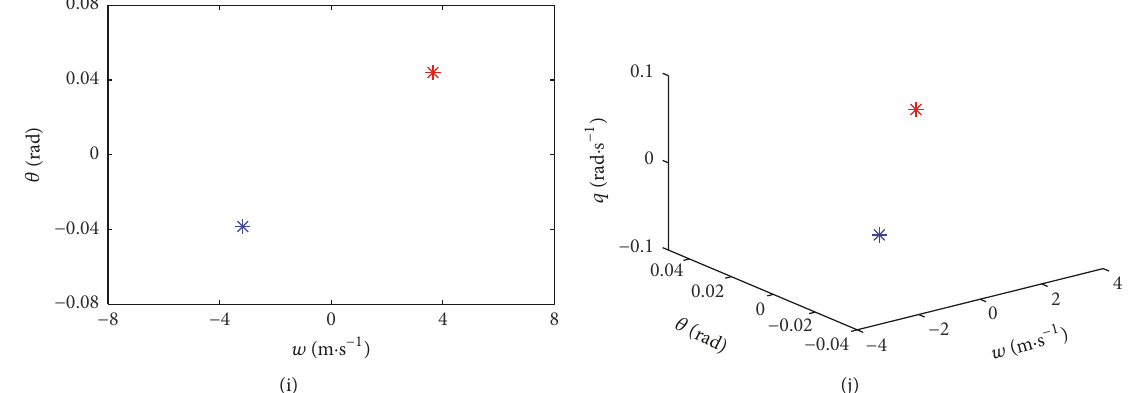
Figure 5: Projections of coexisting attractors on 𝑤 - 𝜃 plane and 𝑤 - 𝜃 -q space.